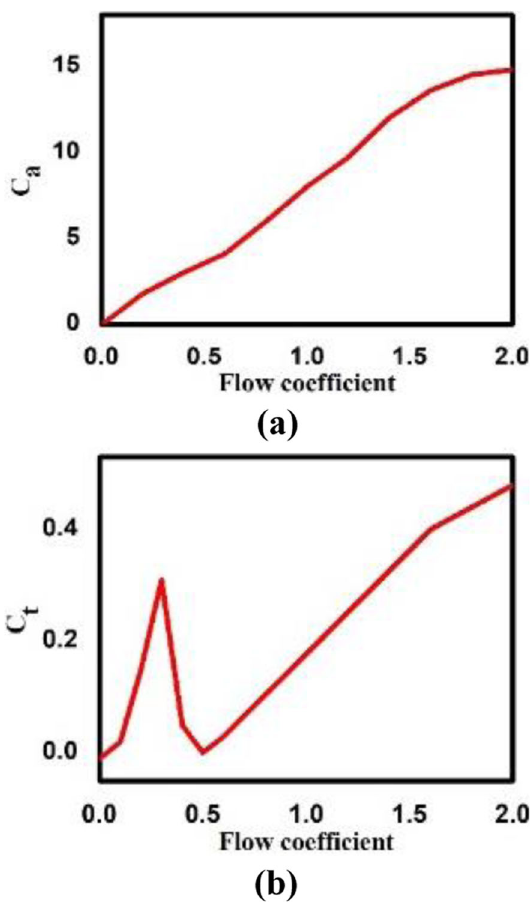
Fig. 9 Characteristics of Wells turbine. a Power coefficient. b Torque versus flow coefficient